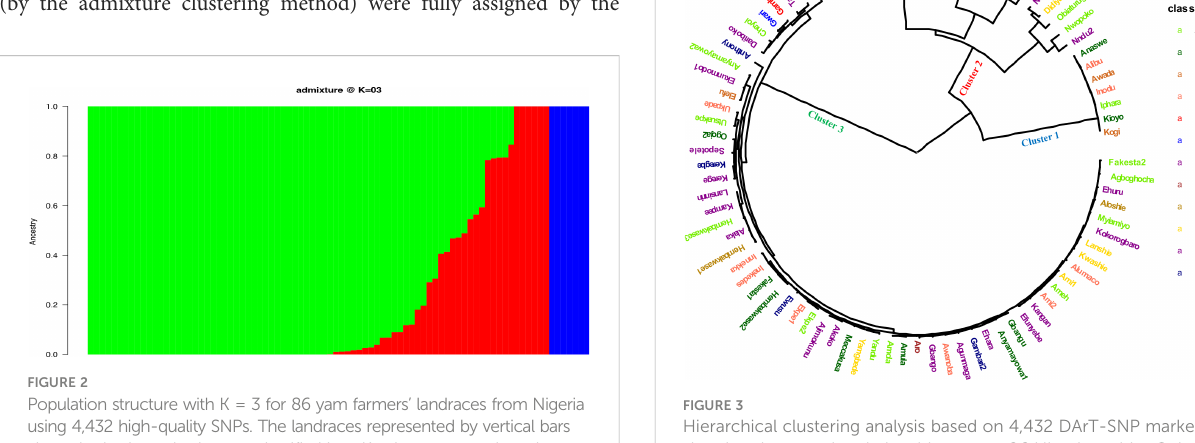
FIGURE 2 Population structure with K = 3 for 86 yam farmers ’ landraces from Nigeria using 4,432 high-quality SNPs. The landraces represented by vertical bars along the horizontal axis were classi fi ed into K color segments based on their estimated membership fraction in each K cluster. Clusters (1, 2, and 3) are represented by blue, red, and green colors, respectively.